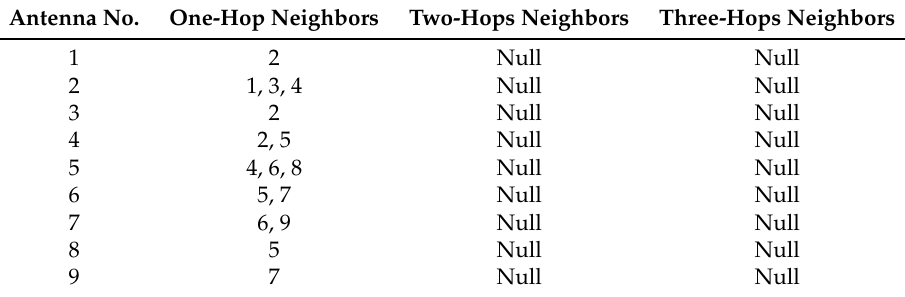
Table 1. The neighbor map of 9 antennas after the first round broadcasting. Antenna No.